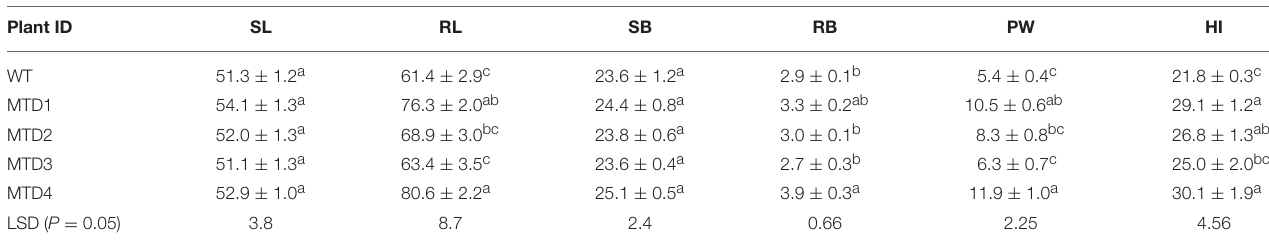
TABLE 3 | Comparison of growth parameters of WT and transgenic lines after harvesting under drought stress conditions. Plant ID